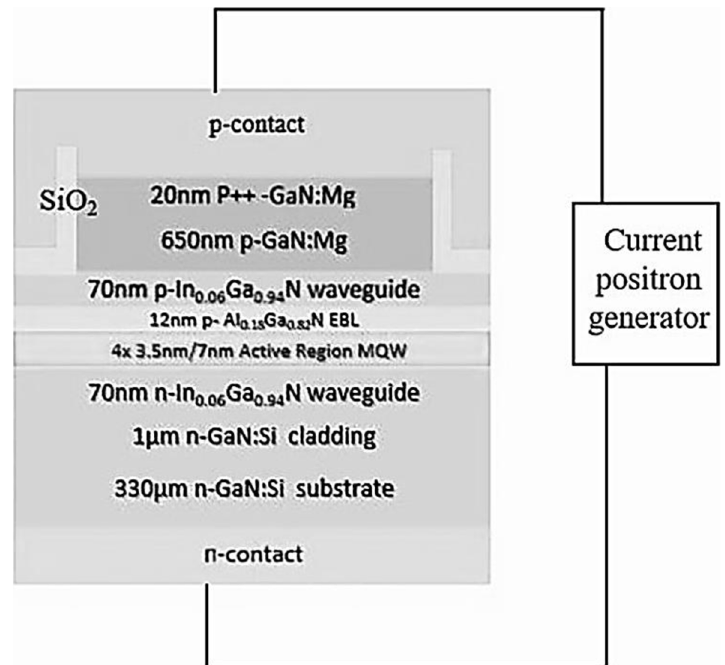
Fig. 6 InGaN-based light emitter of the epitaxial layers. Reproduced with permission [92], Copyright 2016, AIP Publishing; the electric current exists whenever the charges move, and the current-injected device is based on “positron electricity” and “anti-electron electricity.” The positrons are the same as electrons for carrying a charge [89, 90, 92,